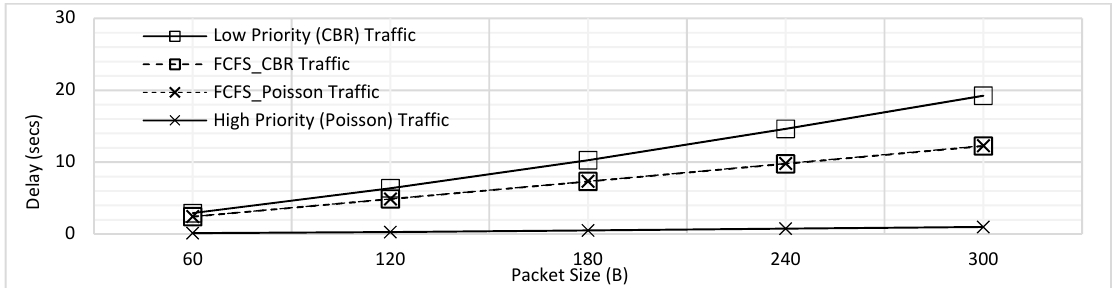
Figure 6. Comparison of PDR for Prioritization without Fragmentation. Sensors 2018 , 18 , x FOR PEER REVIEW